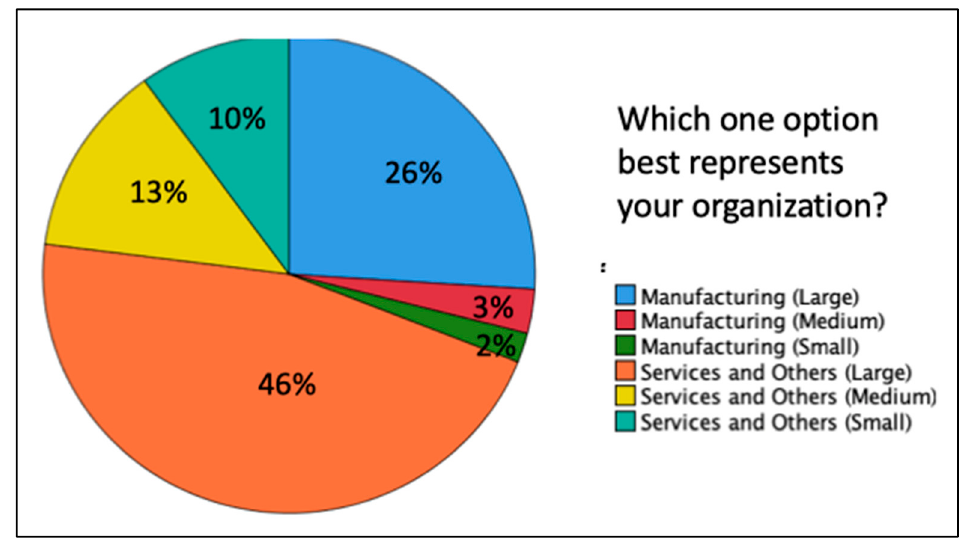
Figure 6 . Company Industry Sector Split. Figure 6. Company Industry Sector Split.